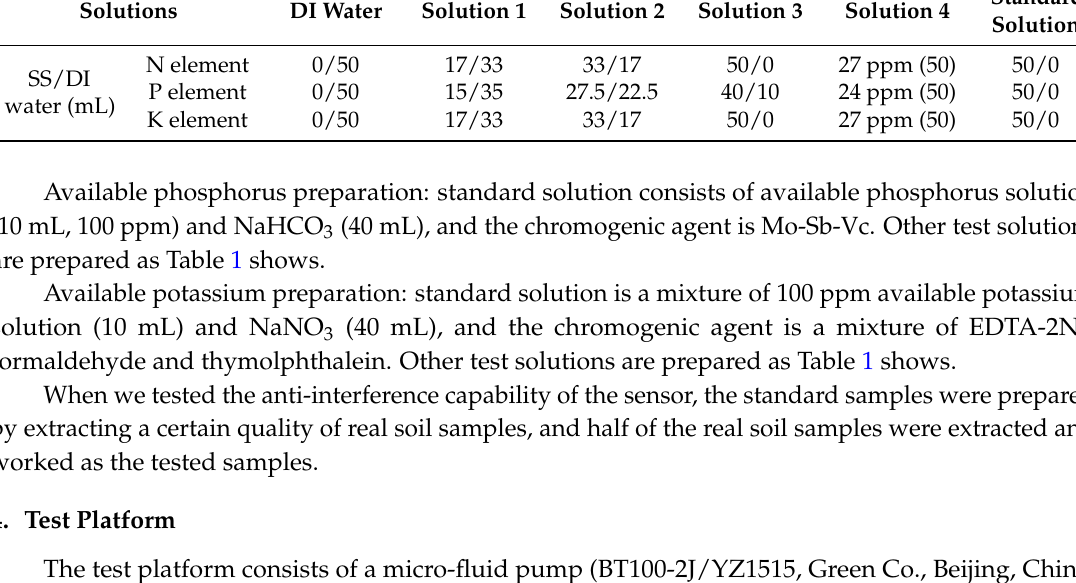
Table 1. Solutions preparation list.